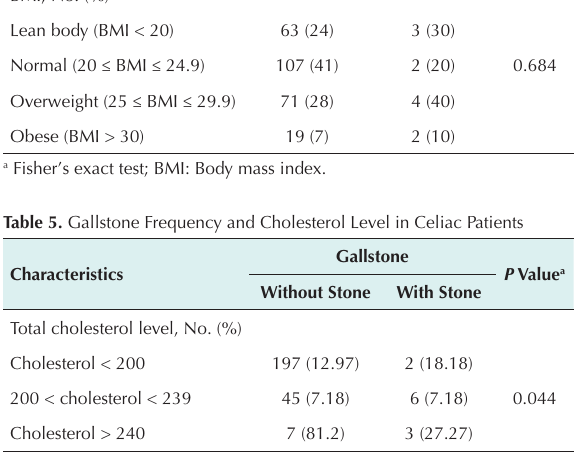
Table 4. Frequency of Gallstone and BMI in Celiac Patients Characteristics